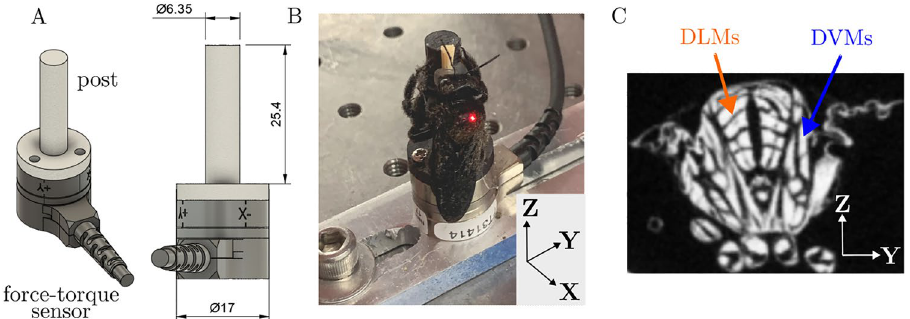
Figure 2. Experimental set-up. ( A ) CAD model. Dimensions are in millimeters. ( B ) Carpenter bee mounted to a carbon fiber post. Note the vibrometer laser spot on the dorsal surface of the bee thorax. The cartesian basis shown in the lower right corner defines force directions. The x and z axes most closely align with the insect’s DVM and DLM muscle groups, respectively. ( C ) MicroCT scan shows a transverse cross section of the insect thorax with flight musculature. The DVM and DLM muscle groups are indicated by arrows. Note that the microCT image shows a honeybee thorax, which has flight musculature that is anatomically similar compared to the carpenter bees considered in this